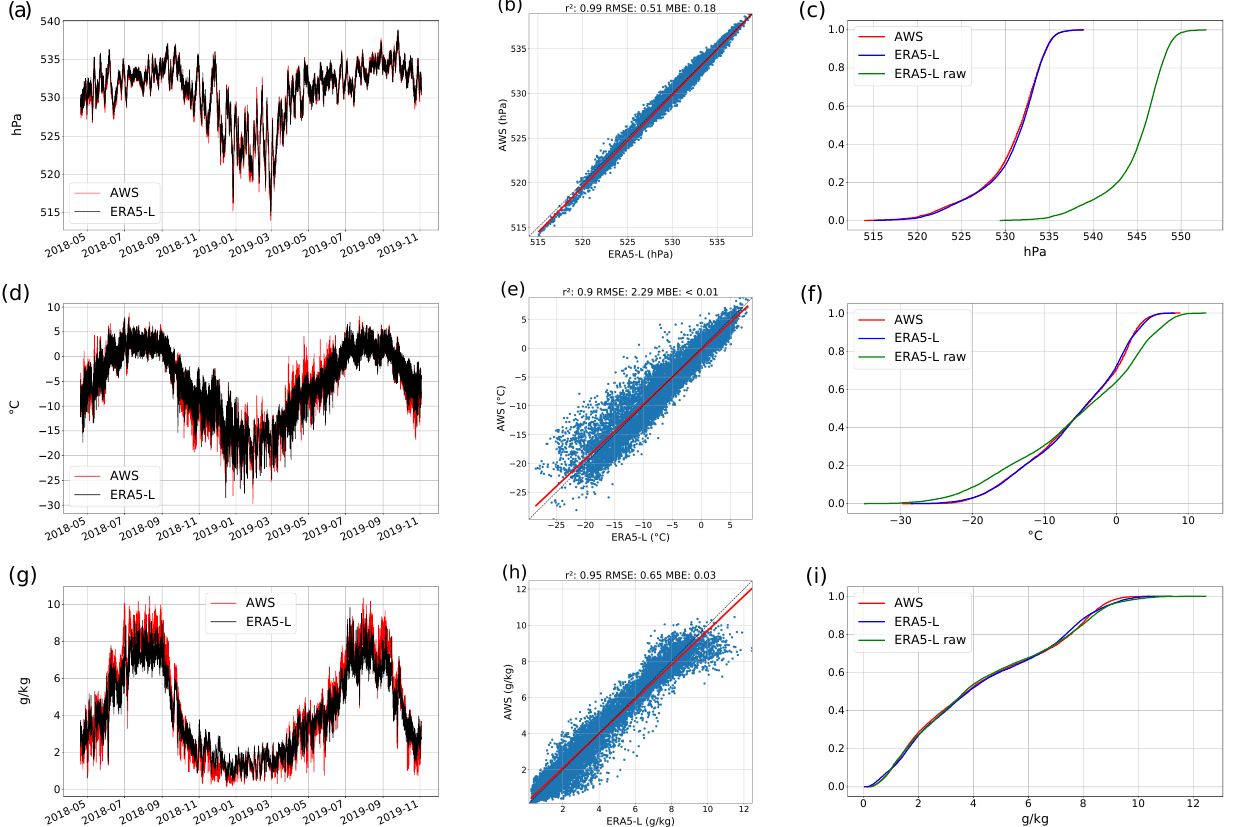
Figure 2. Comparison between measurements of the automatic weather station (May 2018–October 2019) and the down- scaled European Centre for Medium-Range Weather Forecasts (ECMWF) Reanalysis fifth generation-Land (ERA5-L) variables air pressure ( a – c ), air temperature at 2 m ( d – f ) and specific humidity ( g – i ) at the location of the automatic weather station. The time series are presented in the left panels ( a , d , g ), the scatterplots in the middle panels ( b , e , h ) and the cumu- lative distribution functions in the right panels ( c , f , i ). A linear least-square regression model is used for the scatterplots, where the red line shows the regression line. ERA5-L-raw denotes the unscaled ERA5-L variables. In all plots, hourly values are